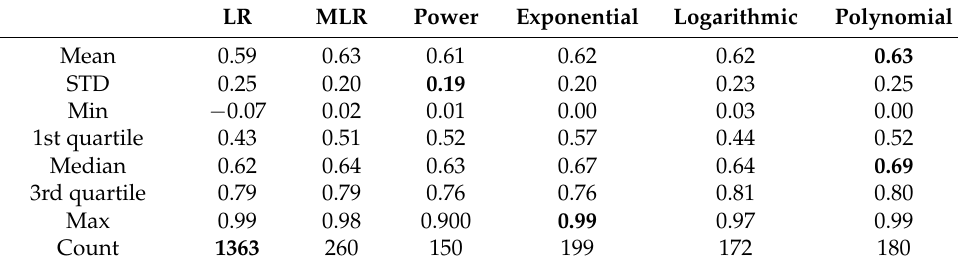
Table 6. Statistical analysis of R 2 in various parametric